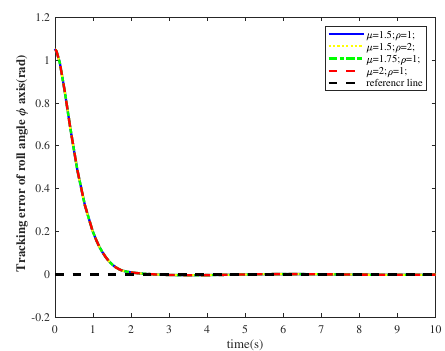
Figure 10. φ of different µ and ρ .